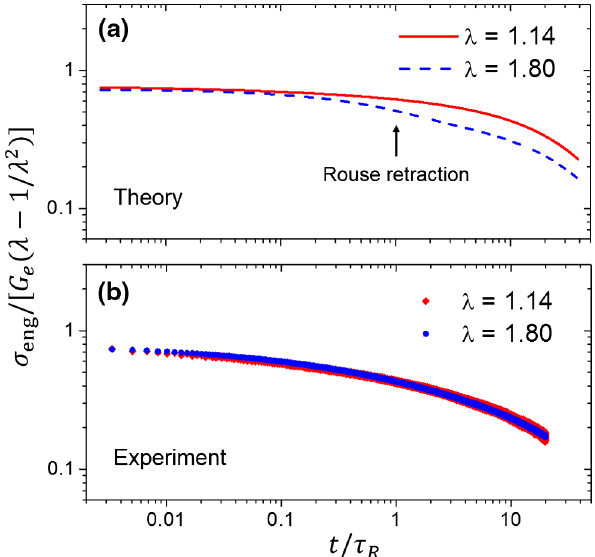
FIG. 7. Stress relaxation behavior at two different strains λ ¼ 1 . 14 and λ ¼ 1 . 80 . Here, following the approach of Ref. [39], the measured engineering stress σ ½ λ − 1 = λ 2 (cid:3) , where λ is the imposed strain. (a) Theoretical by G e predictions from the GLaMM model. (b) Experimental